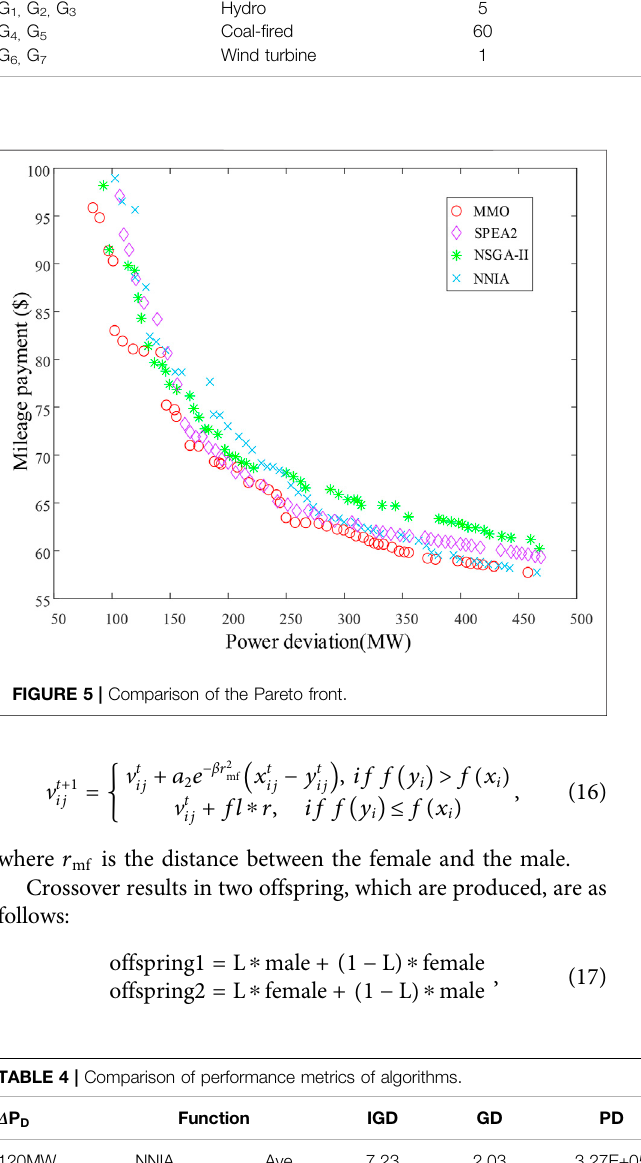
TABLE 3 | Main parameters of AGC units in area A of the two-area LFC model. Unit no.